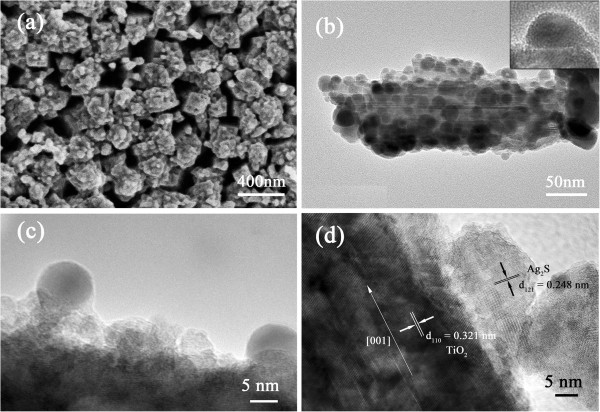
SEM, TEM, and HRTEM images. SEM image of FTO/TiO2/Ag2S (top view) (a), TEM image of a single TiO2 NR covered with Ag2S QDs (b), and HRTEM images of TiO2/Ag2S (c,d).